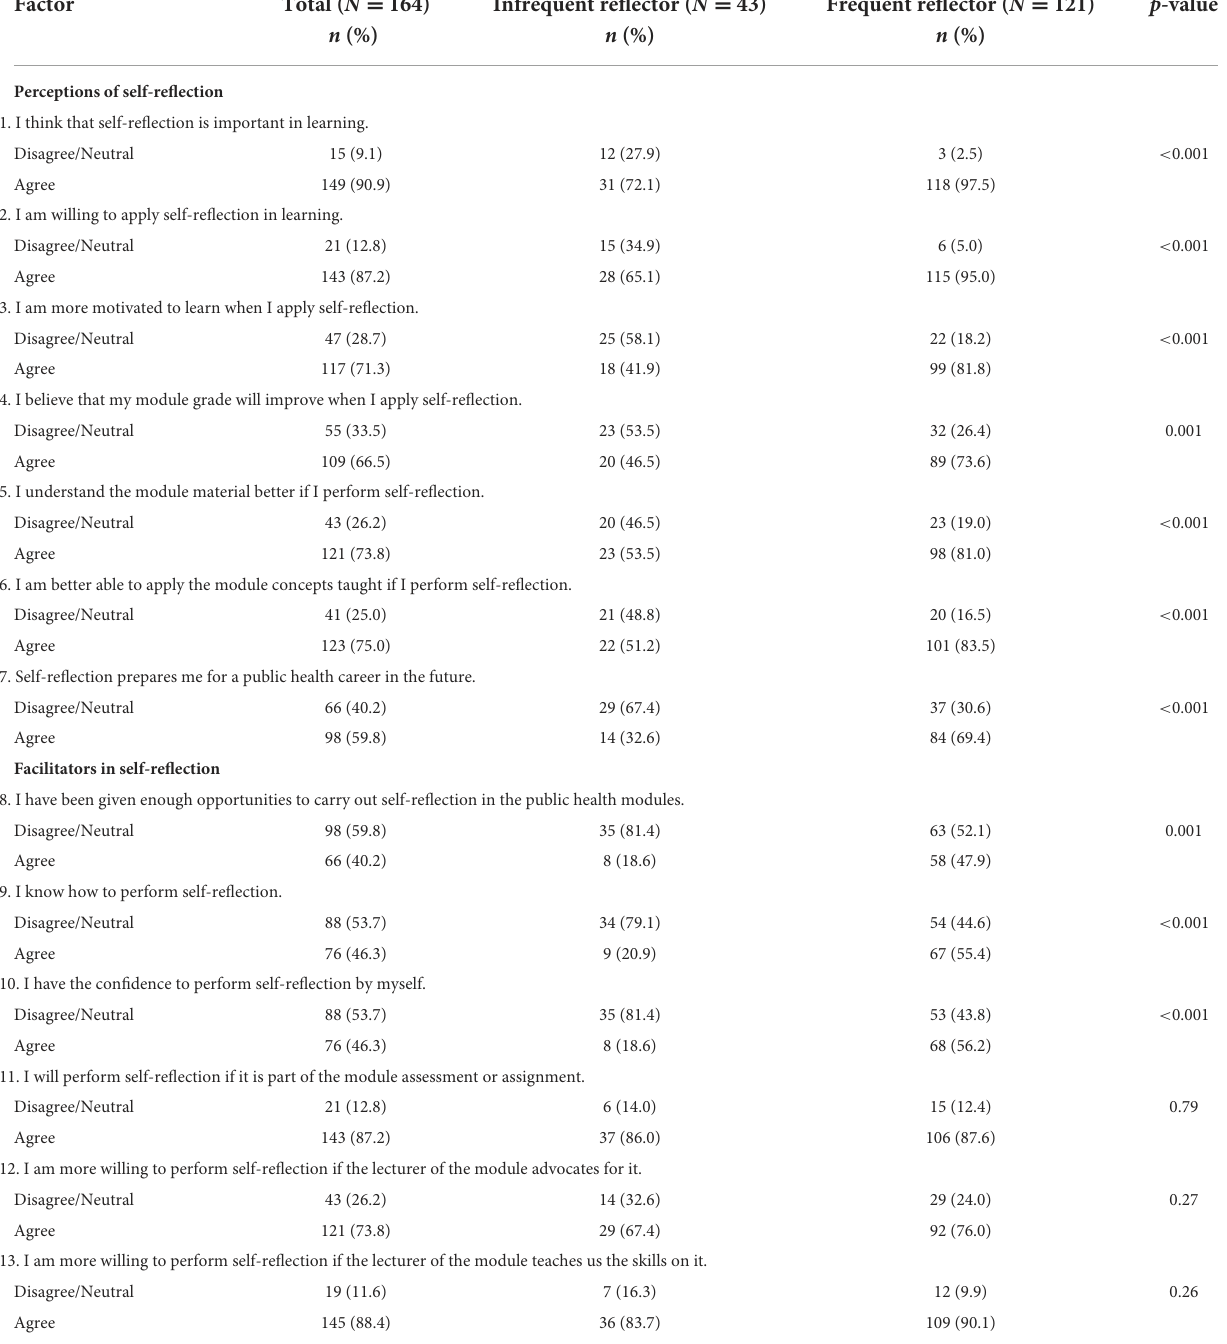
TABLE 2 Perceptions and facilitators in self-reflection in public health modules by reflection frequency. Factor Total ( N = 164)